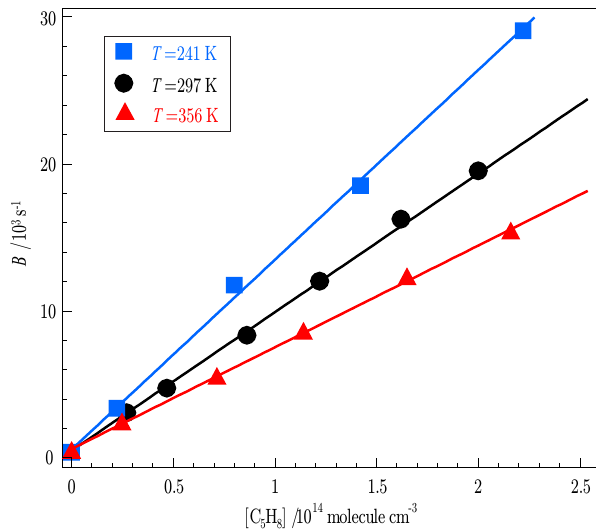
Figure 5. Plots of B parameters vs. associated [isoprene] used to determine k 1 at three different temperatures. Weighted linear fits (Eq. 3) to the data yield (in units of 10 − 11 cm 3 molecule − 1 s − 1 ) : k 1 (241K) = ( 12 . 9 ± 0 . 2 ) from the blue square data points; k 1 (297K) = ( 9 . 43 ± 0 . 14 ) from the black circles and k 1 (356K) = ( 6 . 92 ± 0 . 13 ) from the red triangles. Note that error bars on indi- vidual data points are too small to be seen here (typically a few hundred on decay rates of several thousand per second).